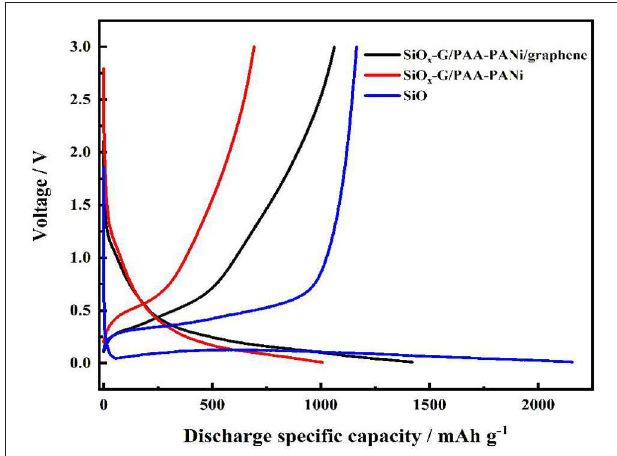
FIGURE 6 | The charge/discharge curves of SiO x -G/PAA-PANi/graphene, SiO x -G/PAA-PANi, and SiO anodes under the current density of 500mA g − 1 .